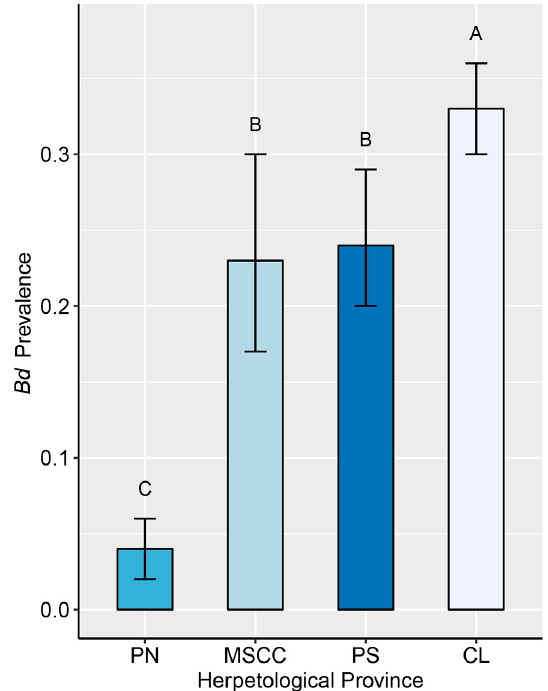
Figure 3. Mean prevalence of infection with Batrachochytrium dendrobatidis ( Bd ) in amphibian assemblages at four herpetological provinces in Costa Rica (with 95% binomial CI). Means followed by a common letter are not significantly di ff erent according to the Tukey’s honestly significant di ff erence (HSD) test at the 5% level of significance. The plot does not display results for Cordillera de Talamanca because no sampling has been conducted for Bd in that province. Symbology: CL—Caribbean Lowlands,